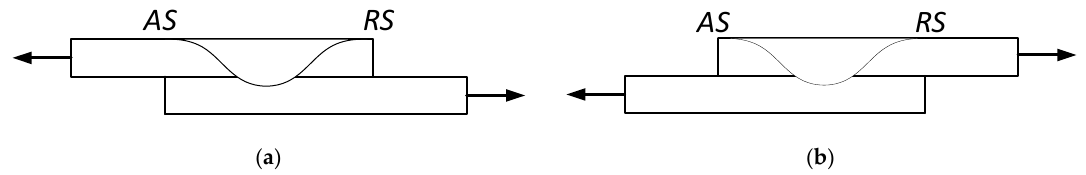
Figure 2. Loading modes in lap tensile–shear testing: ( a ) advancing side (AS) and ( b ) retreating side (RS).